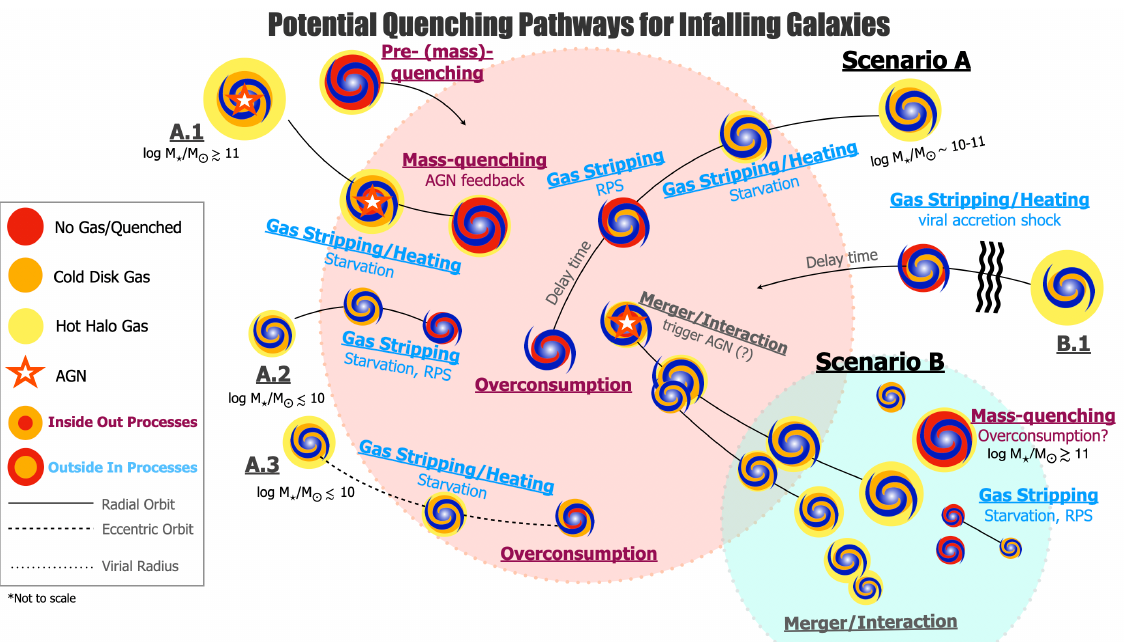
Figure 18. A depiction of potential quenching pathways for galaxies falling into a massive (log M 200 / M (cid:12) (cid:38) 14) galaxy cluster (red dotted line denotes the virial radius). An infalling massive group (log M 200 / M (cid:12) ∼ 13) is depicted in light teal. Galaxies (blue spirals) are roughly sized according to stellar mass, with solid (dashed) lines tracing their radial (eccentric) orbit around the cluster potential. Note: morphological transformations are not shown in this cartoon for simplicity. Yellow and orange denote hot halo and cold molecular disk gas, respectively. Red denotes quenched regions with little to no gas. A star marks AGN activity. Scenarios A and B, along with their variations, are discussed in Section